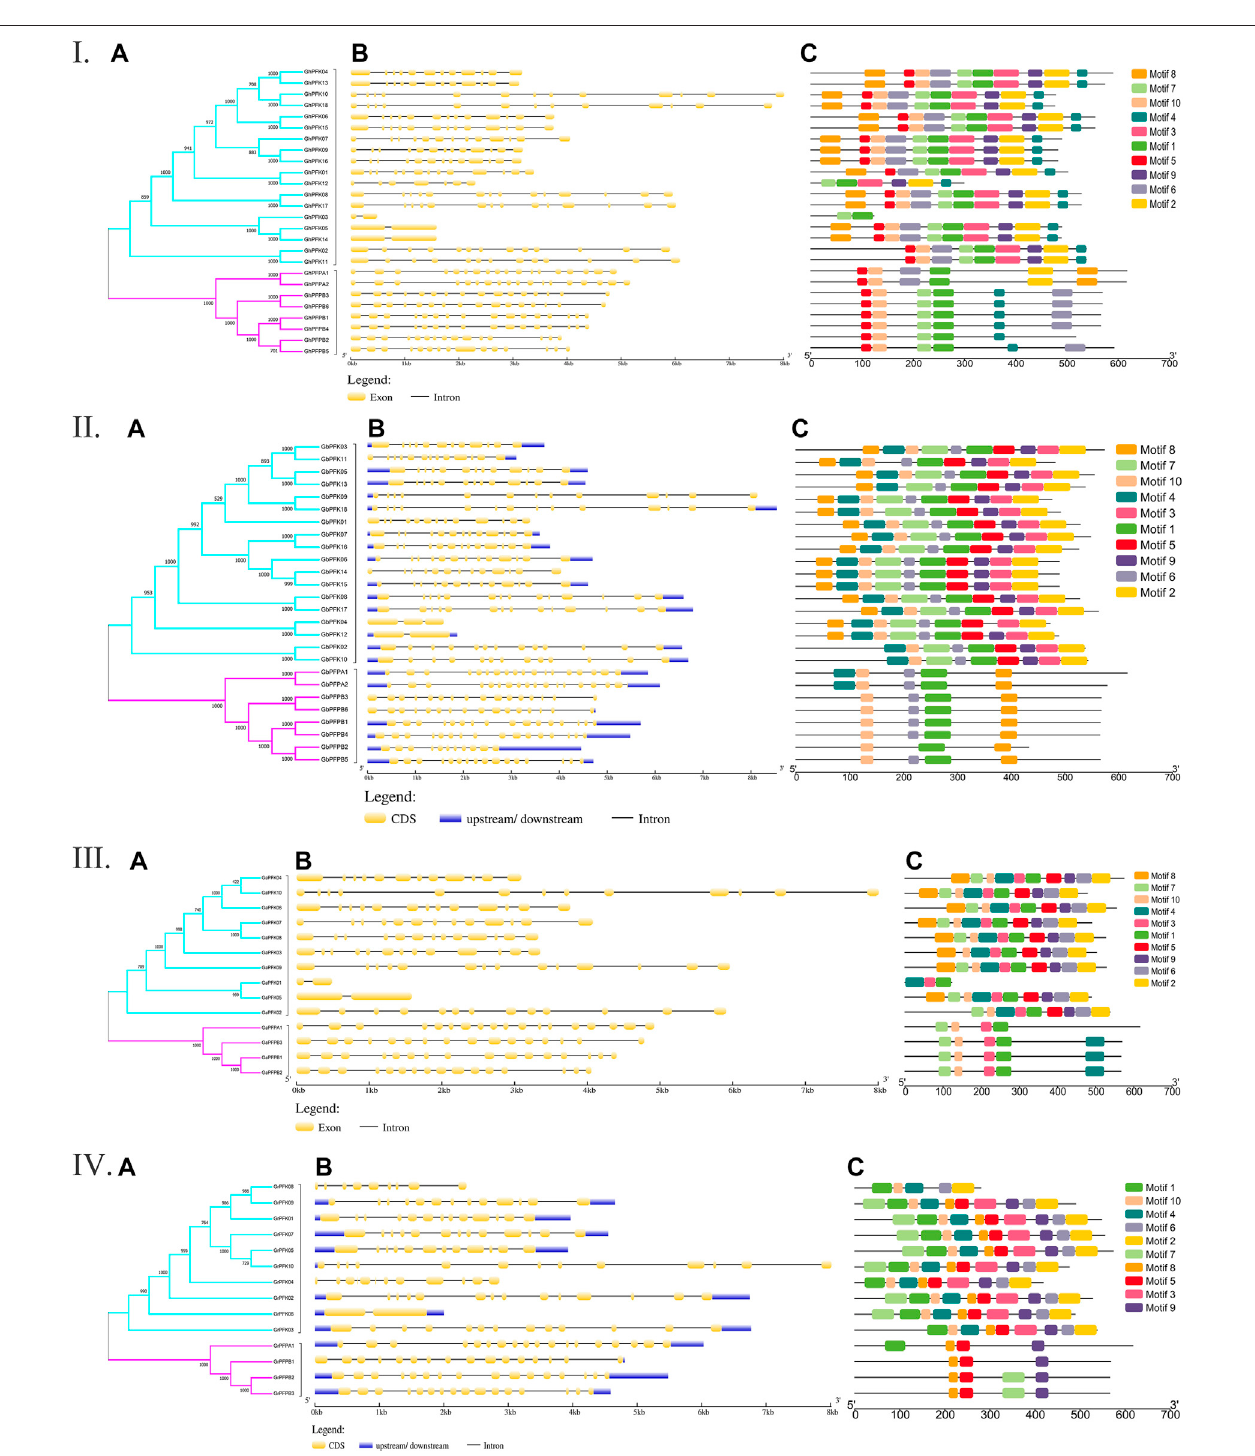
FIGURE 2 | Gene architecture and motif enrichment analysis of PFK proteins in Gossypium species. I. G. hirsutum; II. G. barbadense; III. G. arboreum; IV. G. raimondii . (A – C) stands for phylogenetic relationship, gene structure, and motif identi fi cation in all the Gossypium species, respectively.